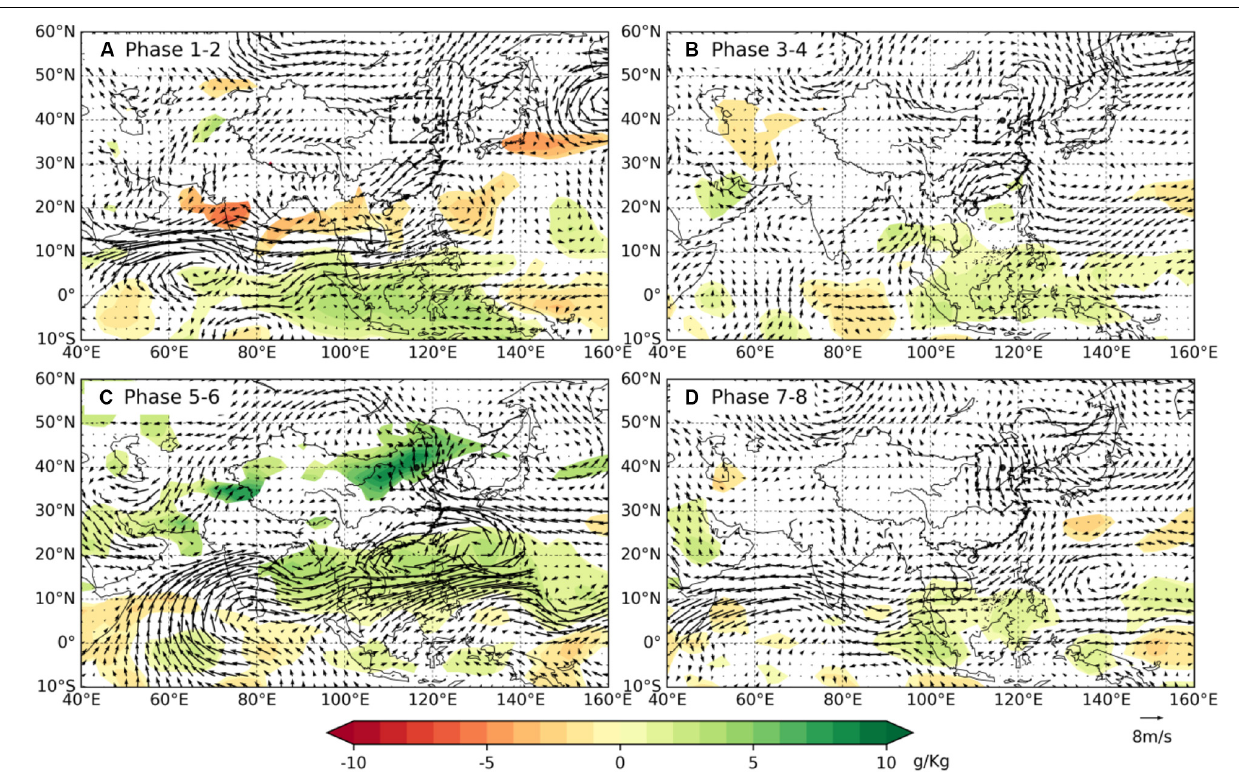
region has a cyclonic circulation anomaly, the Bay of Bengal